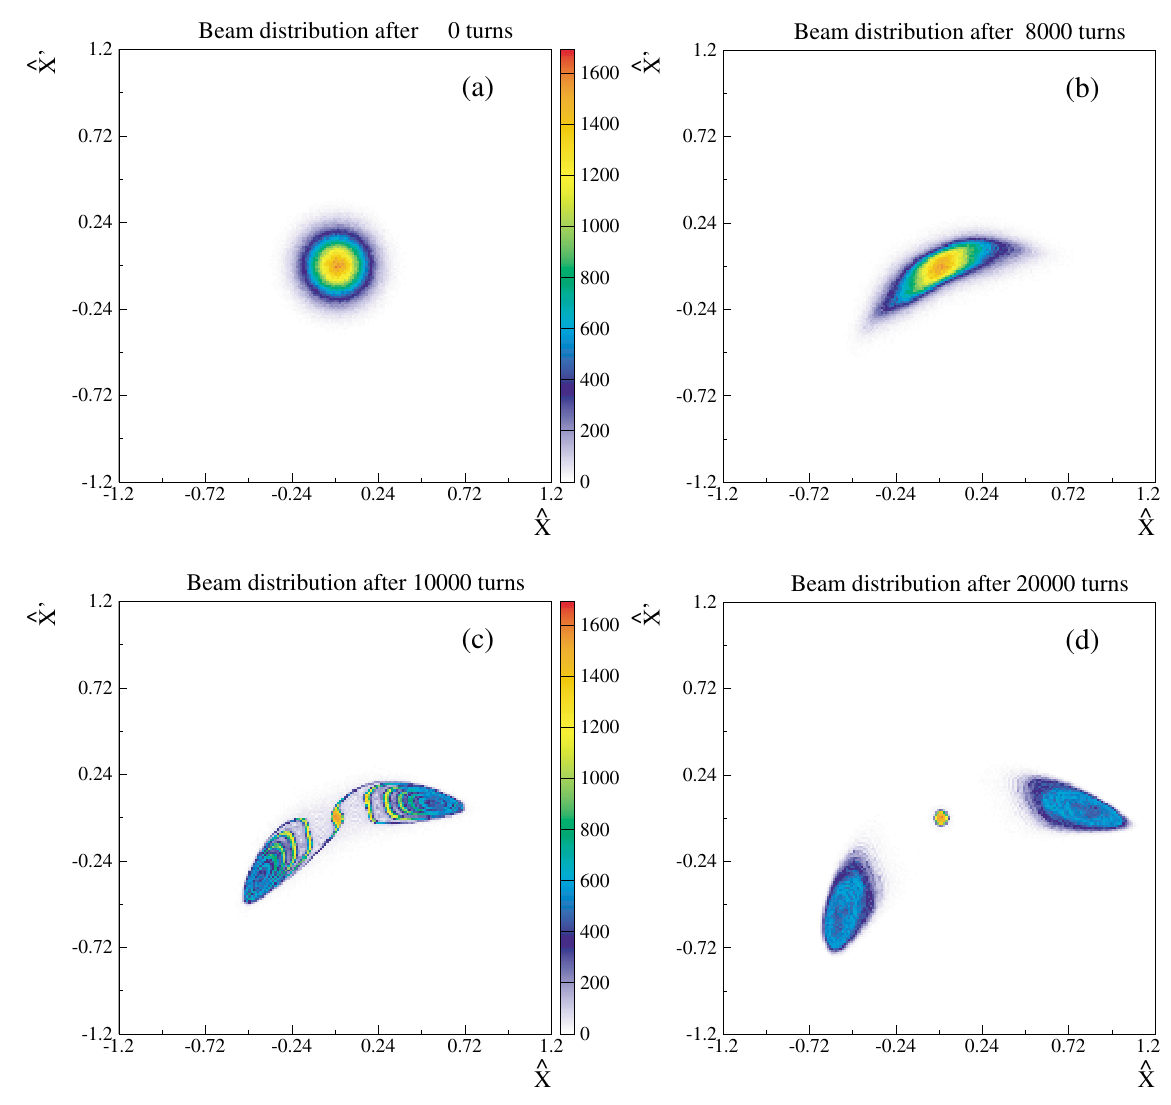
FIG. 2. (Color) Beam distribution during the trapping process with two islands ( 8 : 1 (cid:9) 10 5 initial conditions). The initial distribution is a Gaussian centered on zero, with a standard deviation (cid:21) (cid:1) 0 : 11 , (cid:14) (cid:1) (cid:6) 1 . Only a few particles are left near the origin of phase